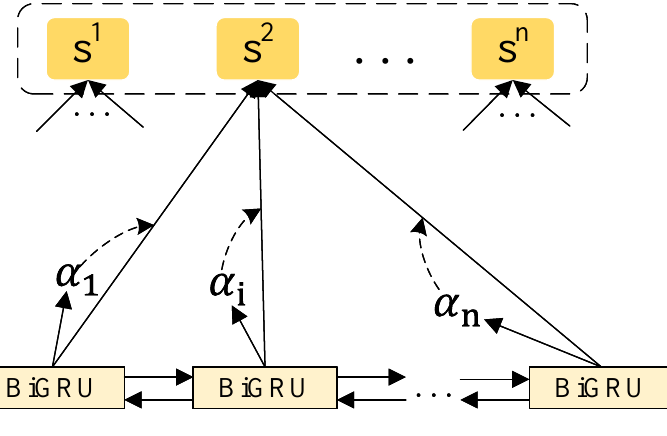
Figure 2. Attention